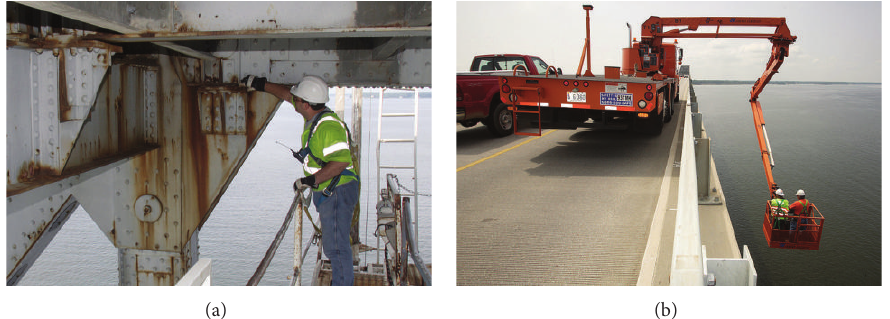
Figure 1: Bridge inspection in practice (photos taken in 2007 courtesy of Virginia Department of Transportation, VDOT; creative commons rights are reserved to VDOT): (a) steel bridge joint inspection with complex geometric configurations and (b) hard-access inspection of the side of the concrete bridge